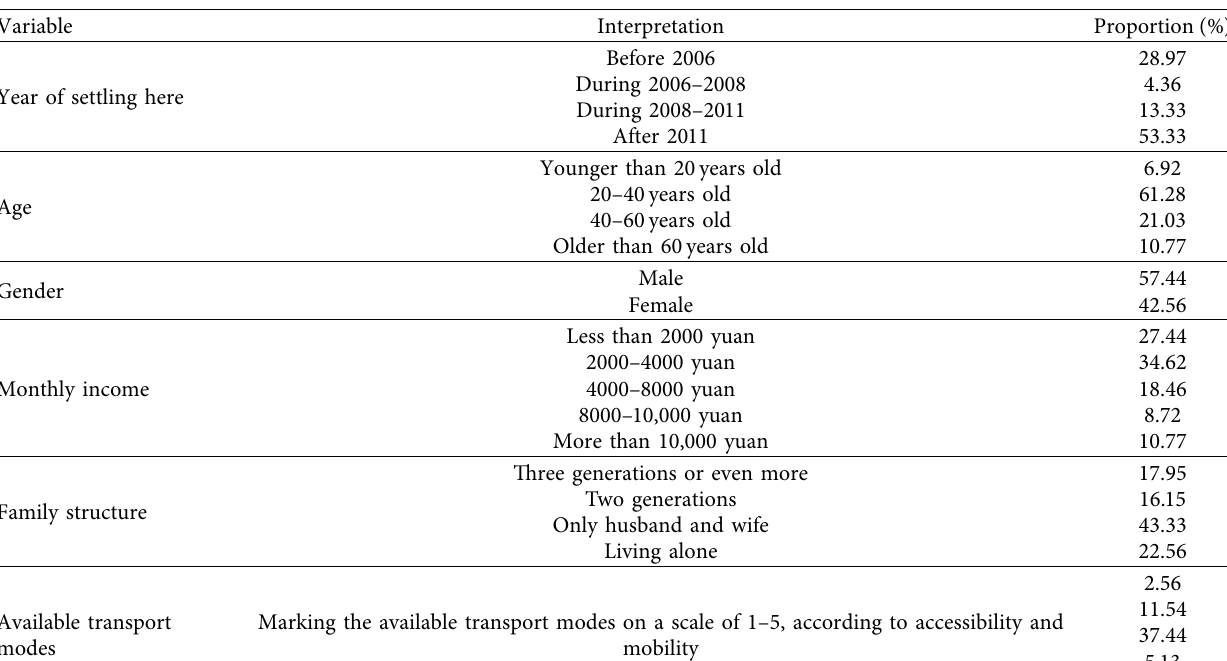
Figure 1: Location of Chenggong in Table 1: Descriptive statistics of the total sample residents.